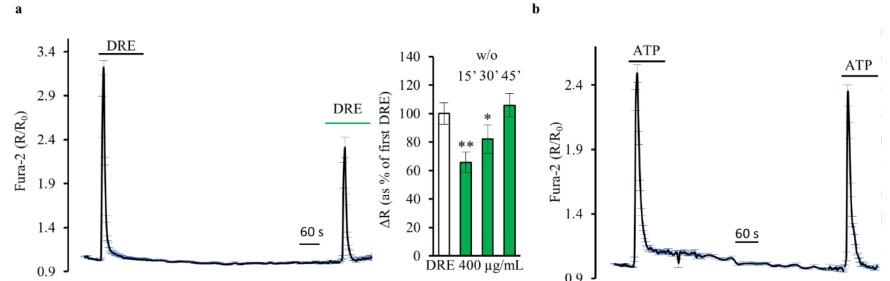
Figure 6. Does DRE activate plasma membrane receptors? ( a ) Response of Fura-2-loaded HEK293 cells to two repeated exposures to DRE (400 µ g/mL) separated by a 15 min washout ( w / o ). The reported values are means ± SE from all the responsive cells on a single coverslip. Right inset: Changes in the Fura-2 ratio in Ca 2+ -containing solutions in response to repeated exposures to DRE (400 µ g/mL) separated by washouts of different durations (15 (cid:48) , 30 (cid:48) , and 45 (cid:48) ). The second response to DRE is normalized to the first one. The reported values are means ± SE from all the responsive cells of all experiments performed (** p < 0.01 vs. first DRE, * p < 0.05 vs. first DRE) ( b ) Response of Fura-2-loaded HEK293 cells to two repeated exposures to ATP (100 µ M) separated by a 15 min washout ( w / o ). The reported values are means ± SE from all the responsive cells on a single